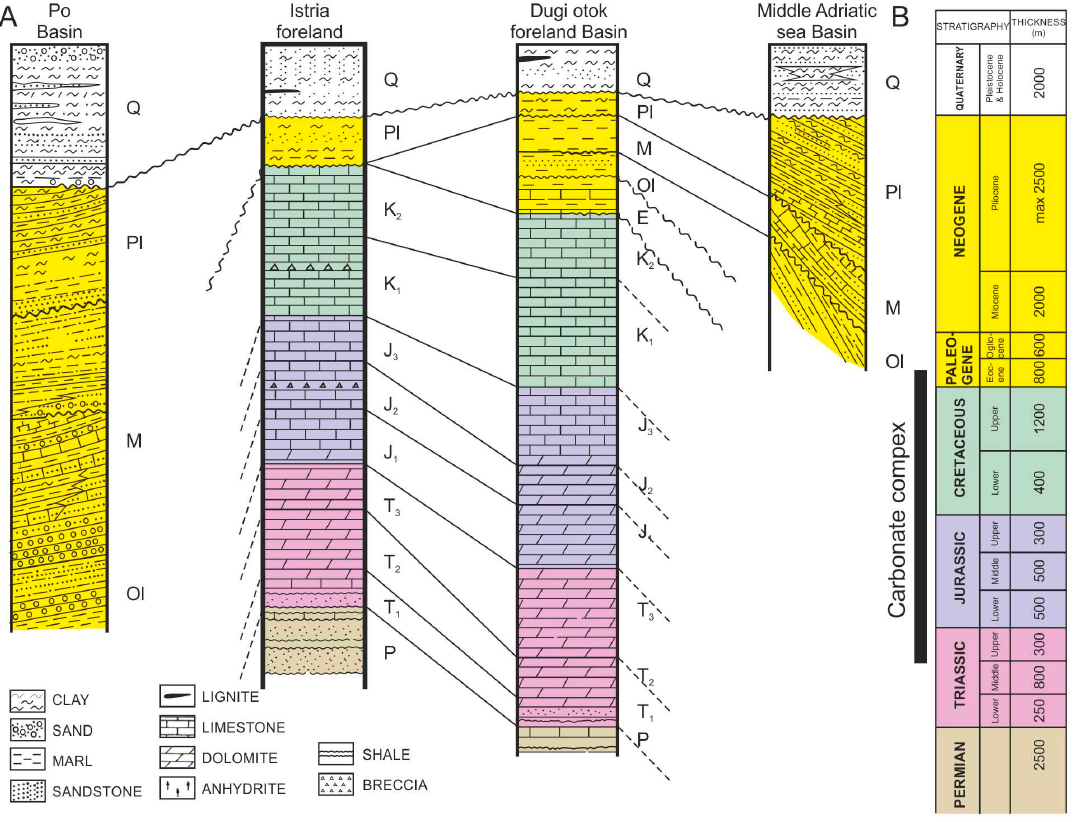
Figure 2. Schematic cross-section A–B of the Adriatic offshore (NW–SE, modified after [26–29]; locations in Figure 4).